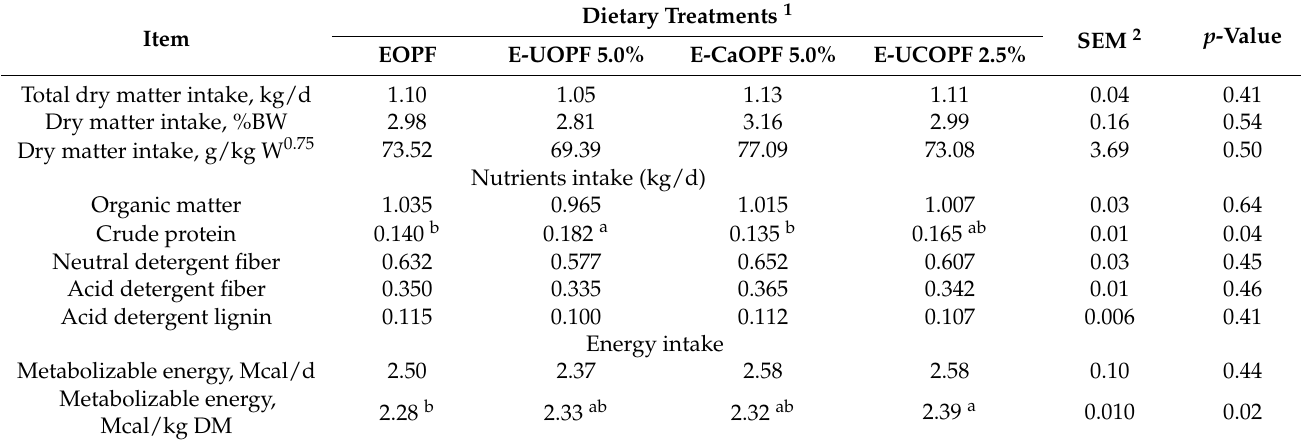
Table 3. Effect of ensiled oil palm fronds supplemented with urea-calcium hydroxide on feed and nutrient intake in goats.